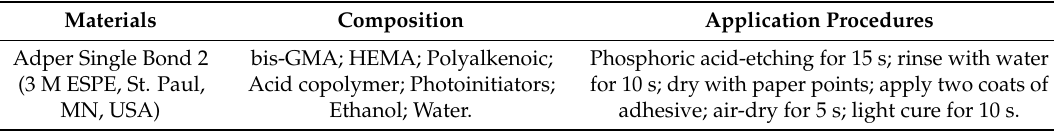
Table 1. The adhesive used in this